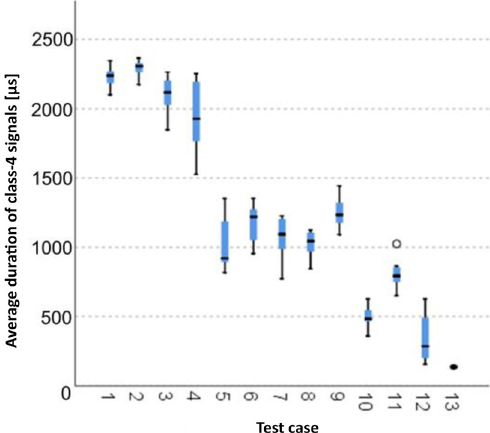
Figure 13. Graphic presentation of the Kruskal–Wallis test results for independent samples: average duration of class-4 signals.